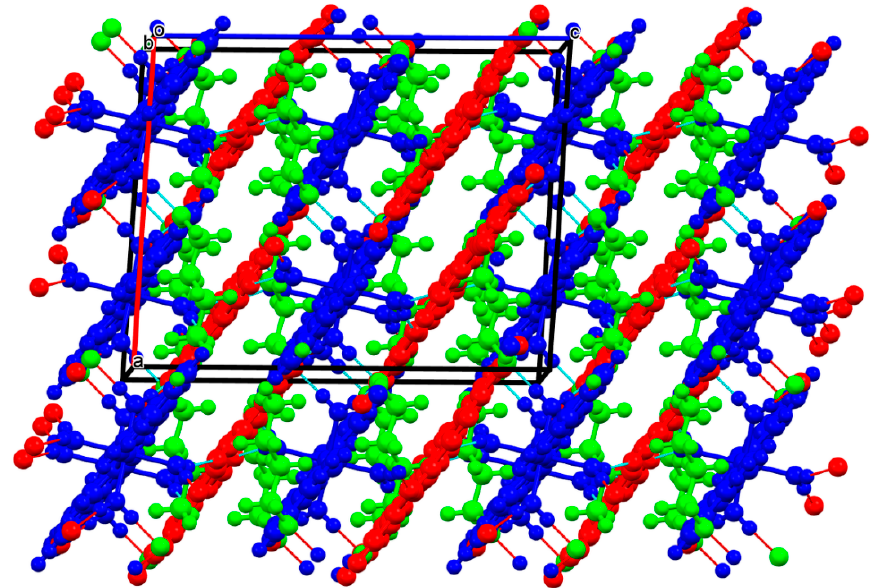
Figure 4. Packing diagram of compound 1 , watched along b . Color code: dark blue: the [Mg(H 2 O) 4 (4,4 ′ -bipy) 2 ] unit; red: the cyclopentadienide anions; green: the butanol molecules.